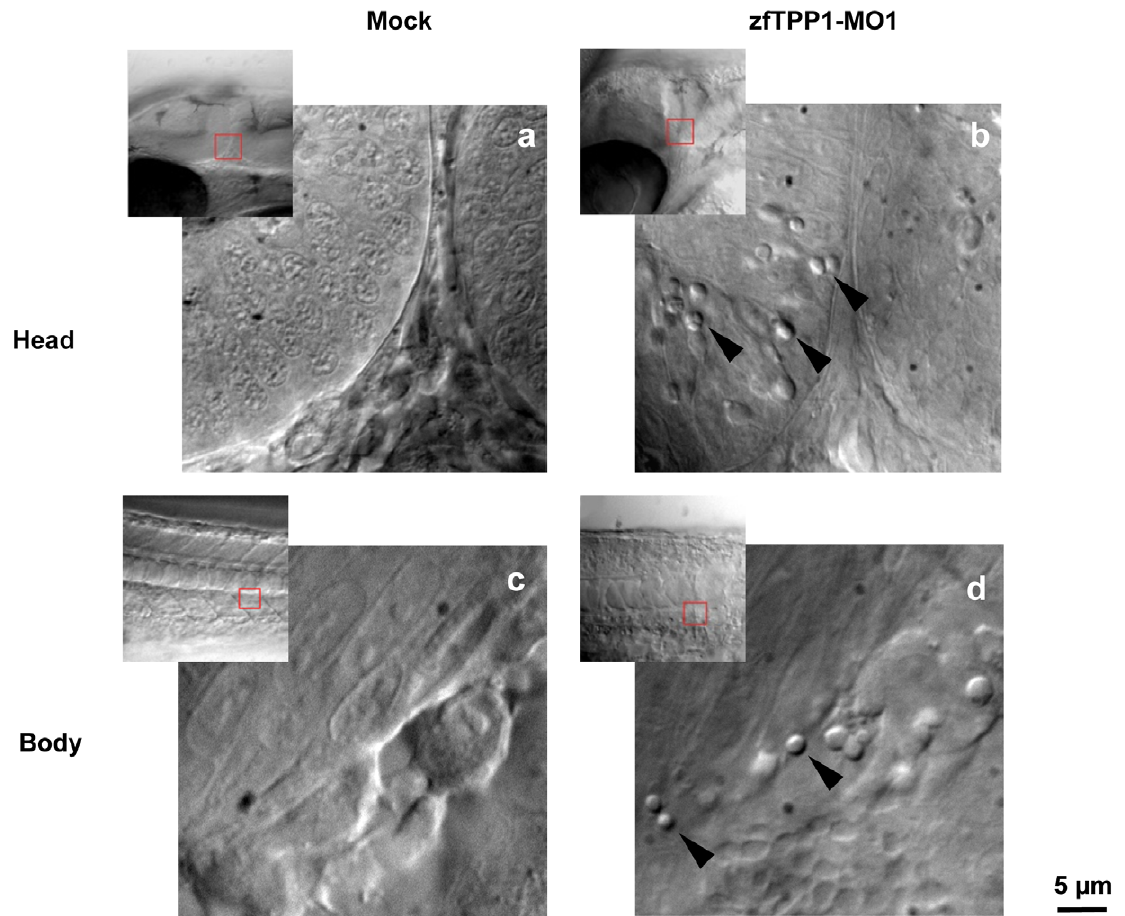
Figure 7. zfTPP1 knockdown leads to accumulation of button-like structures. Nomarski DIC images of regions of the head (a, b) and body (c, d) of mock and zfTPP1 MO1 (6 ng) injected embryos were obtained at 28 hpf. Button-like structures are indicated by arrows. Scale bar, 5 m m.